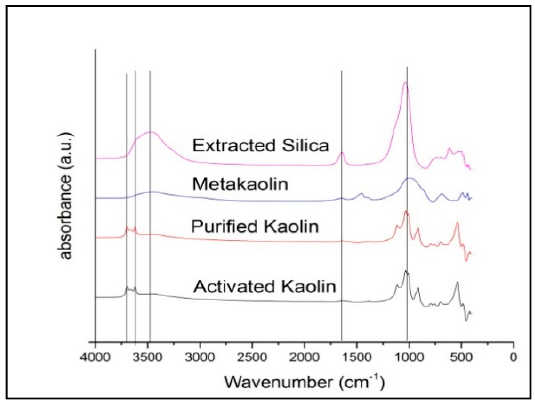
Figure 2. Fourier Transform-Infra Red spectra for the raw precursor materials.